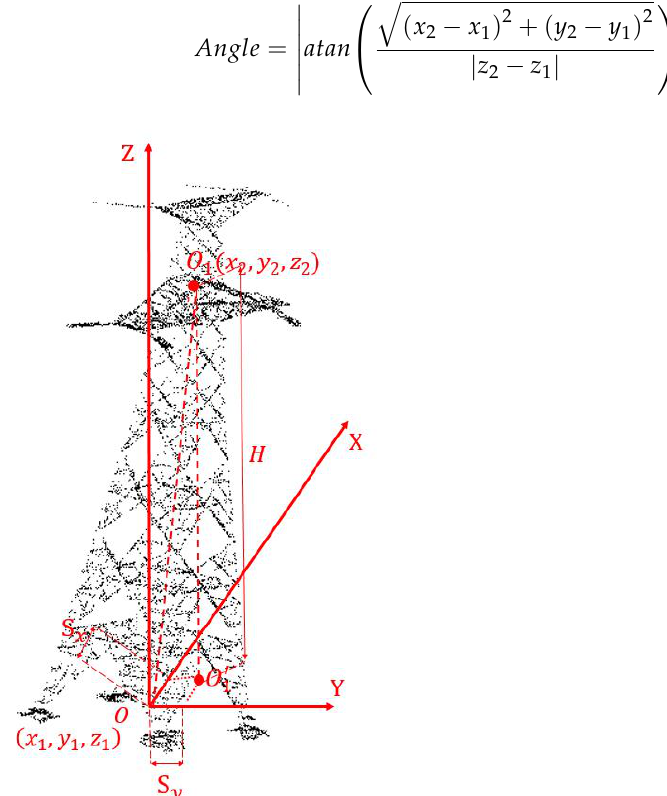
Figure 11. Schematic diagram of tower tilt angle calculation.